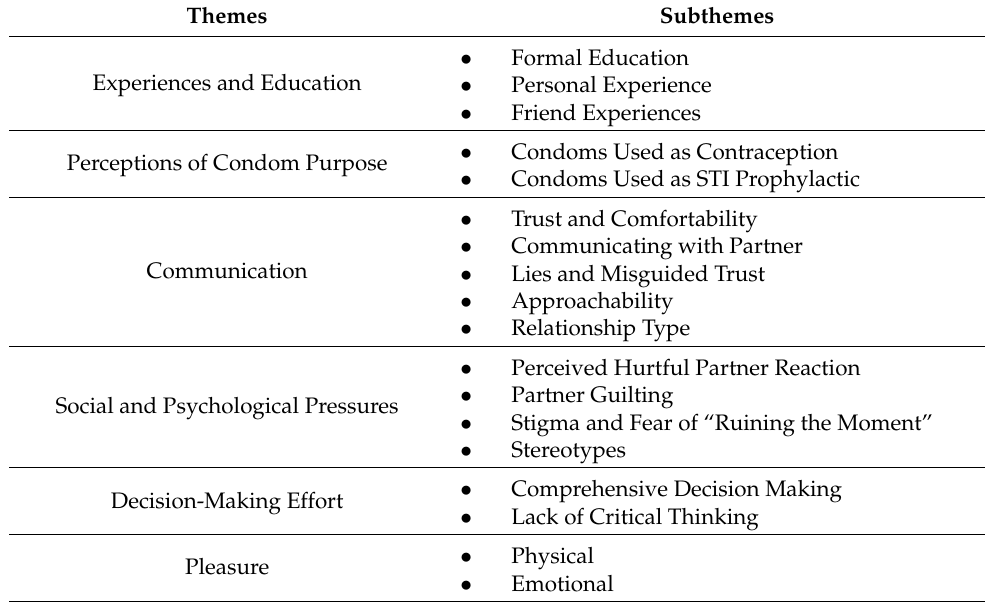
Table 1. List of themes and sub-themes identified from 9